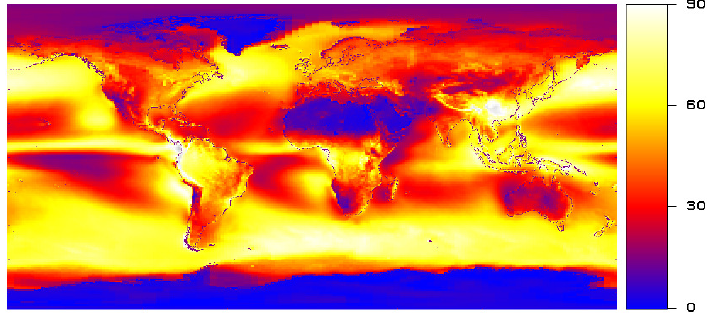
Figure 3. 2000–2018 mean cloud effect CERES RSR. The scale is in W/m 2